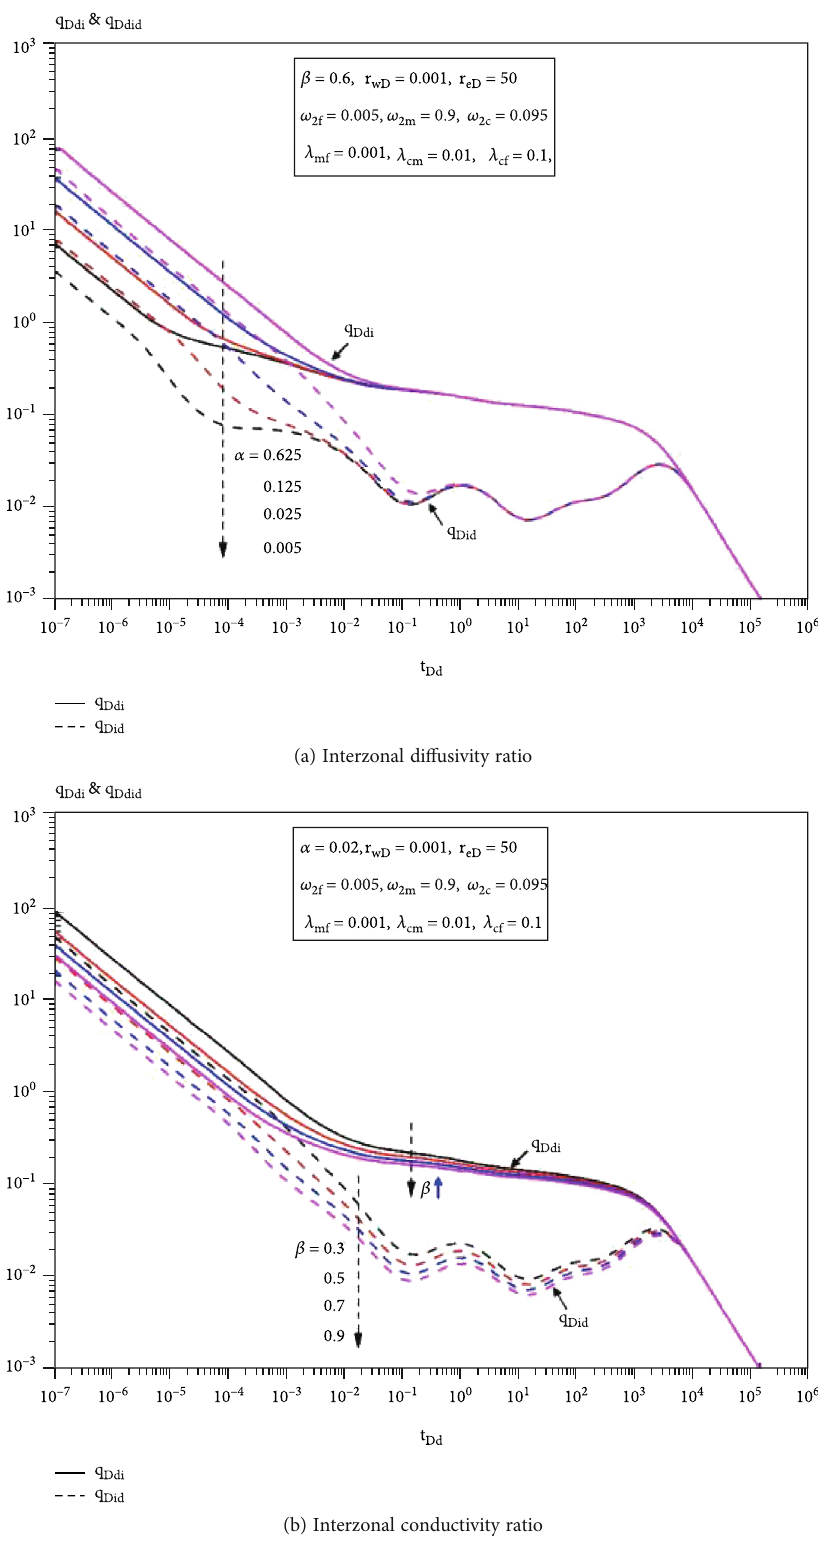
Figure 12: New rate decline curves of an AFVW in a pore-cavity-fracture carbonate reservoir under di ff erent interzonal di ff usivity ratios and interzonal conductivity